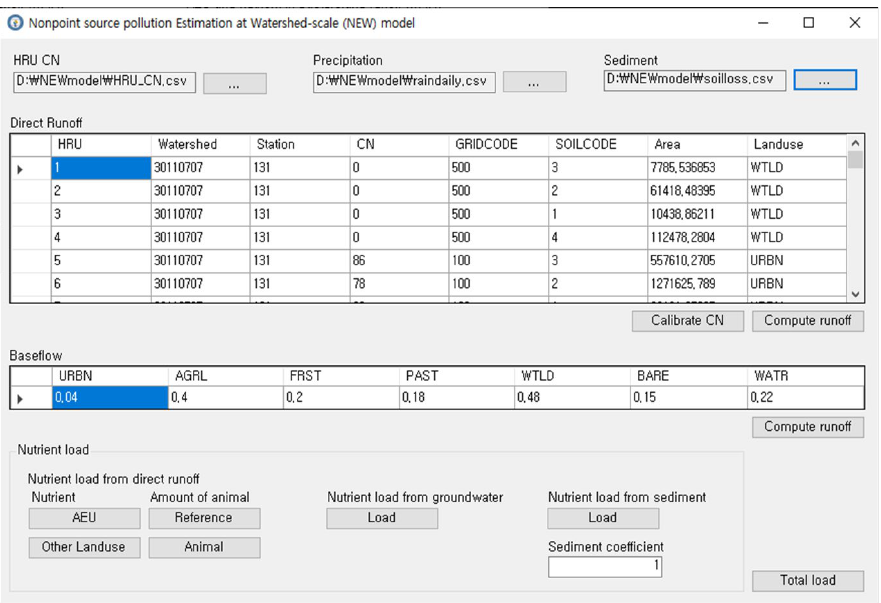
Figure 5. Graphical user interface (GUI) for estimating monthly streamflow and NPS pollutant loads. Water 2022 , 14 , x FOR PEER REVIEW